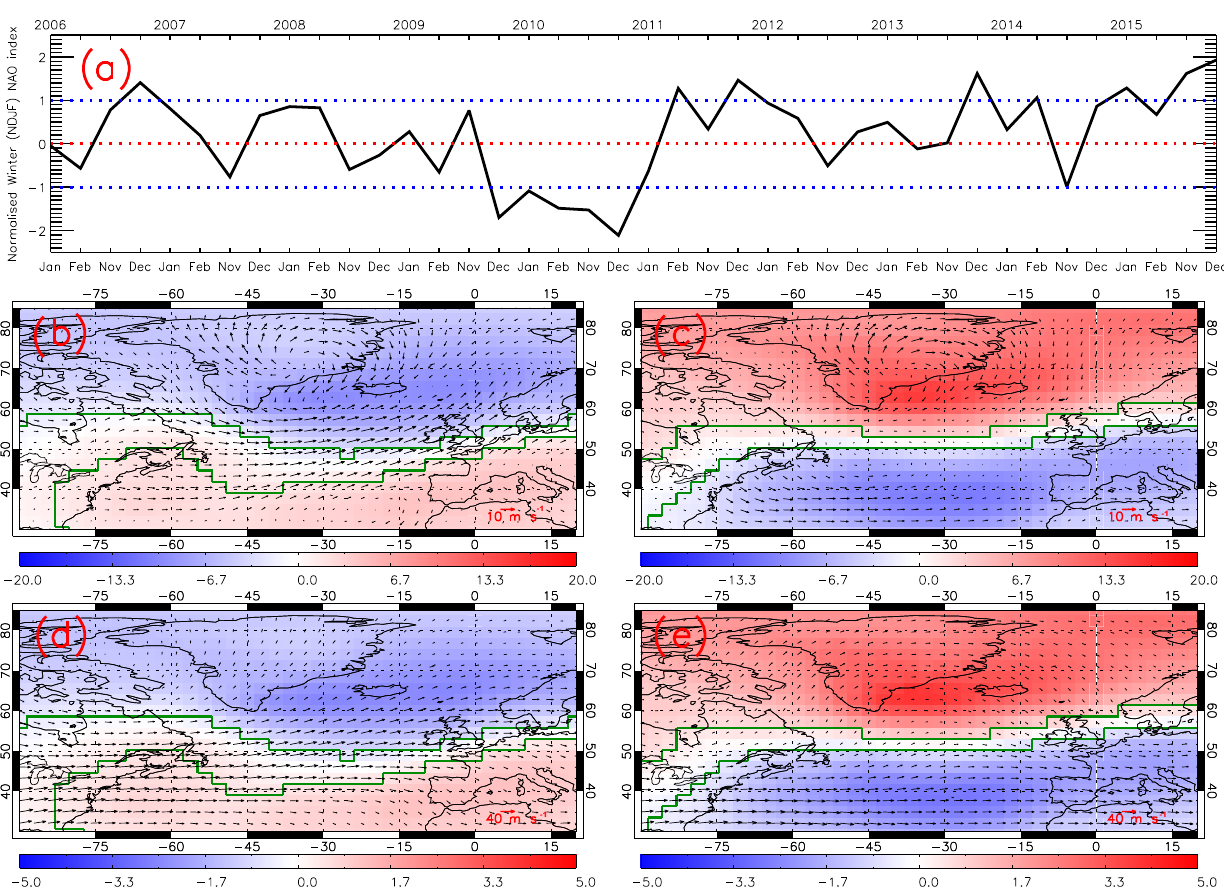
Figure 1. (a) The Climate Research Unit (CRU), University of East Anglia, wintertime (November–December–January–February, NDJF) normalised North Atlantic Oscillation Index (NAOI) from 2006 to 2015. Red and blue lines show the 0 and 1 standard deviation thresholds, where NAOI values outside this range ( − 1.0 to 1.0 SD) are classed as significant phases. Panels (b) and (c) show the NAO positive and negative-phase surface pressure anomalies (ERA-Interim data) relative to the wintertime average. Panels (d) and (e) show the same as (b) and (c) but for 10km altitude. Wind vectors are overplotted for the respective NAO phases and altitudes. Green polygon-outlined regions highlight significant differences at the 99% confidence level based on the Wilcoxon rank test